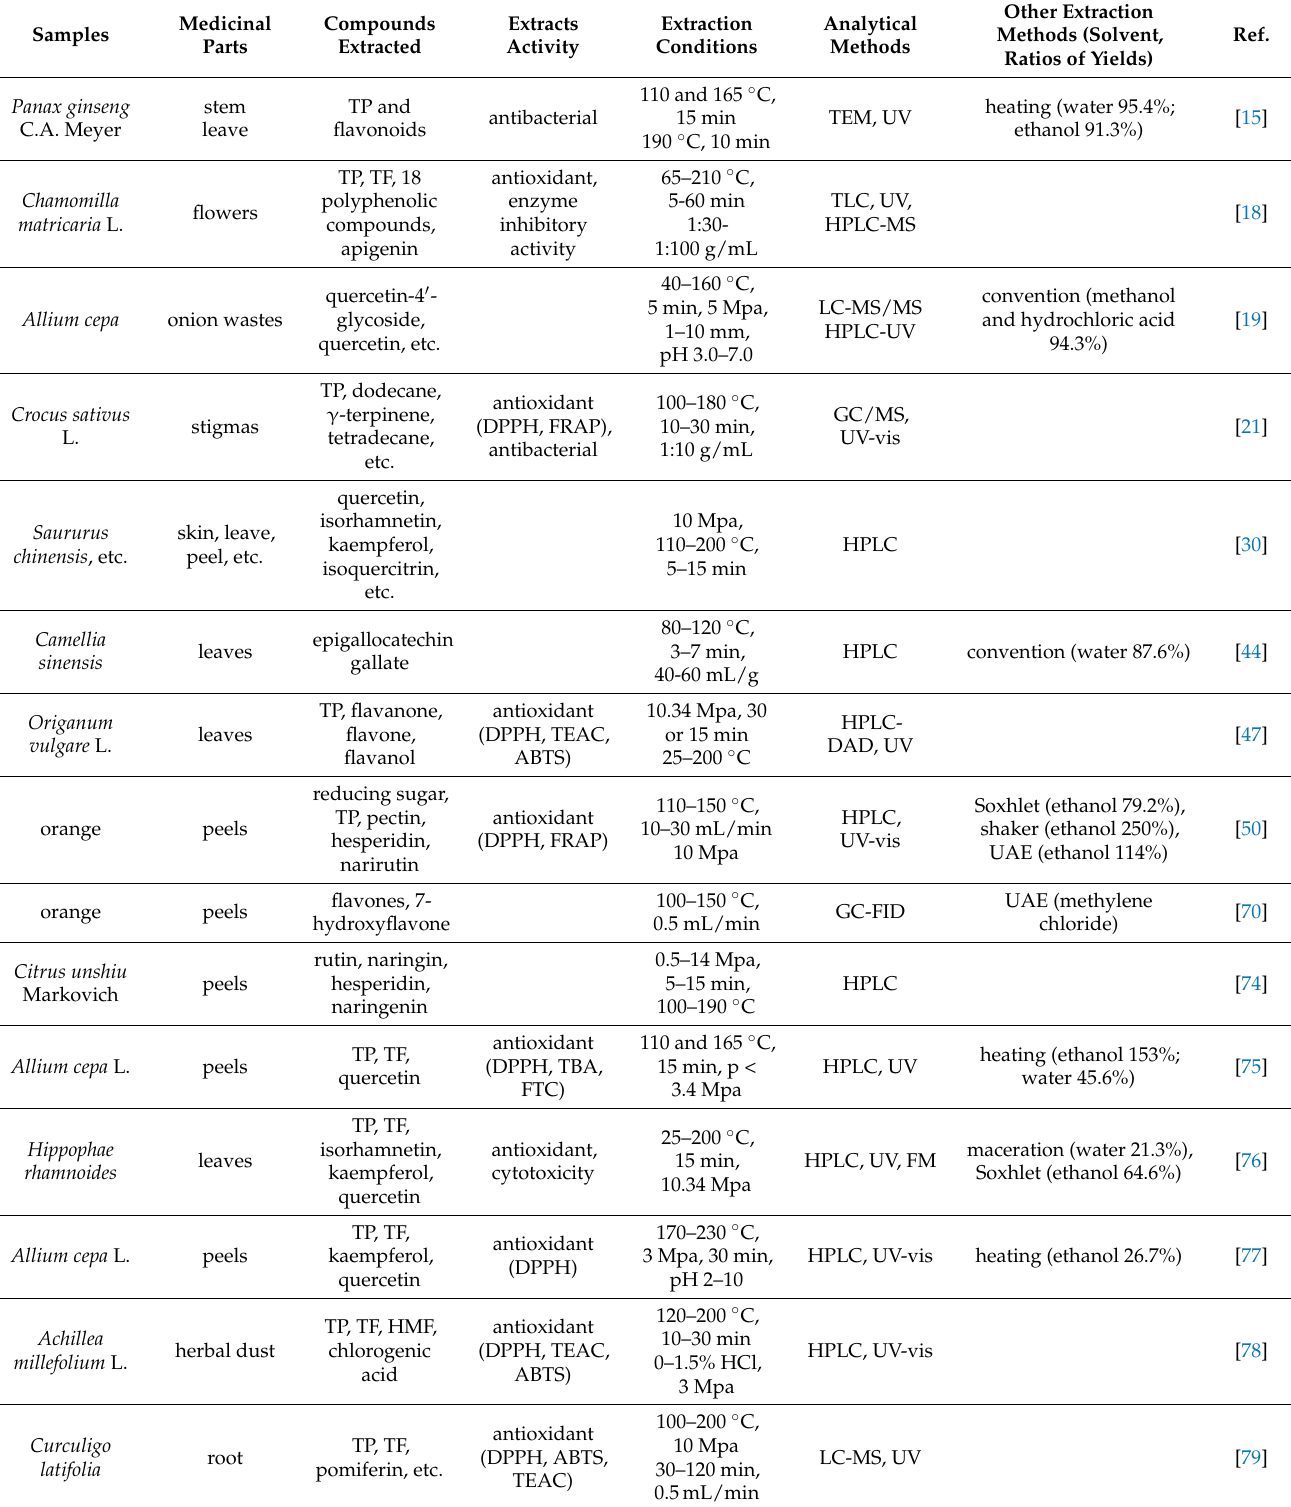
Table 1. SBWE of